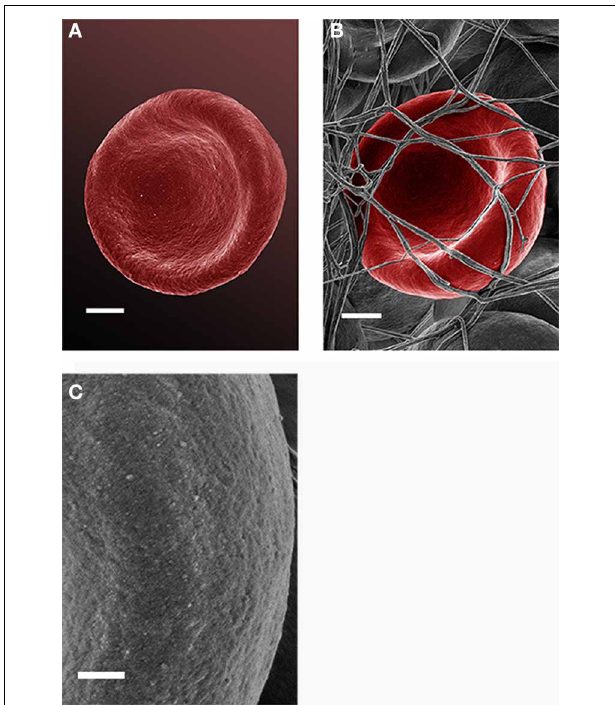
FIGURE 6 | Red blood cell from a normal SF AD individual (scale = 1 µ m) (A) ; where thrombin is added to whole blood; the cells keep their discoid shape (scale = 1 µ m) (B) ; high magnification of RBC membrane, showing globular structure (Scale = 100nm) (C)